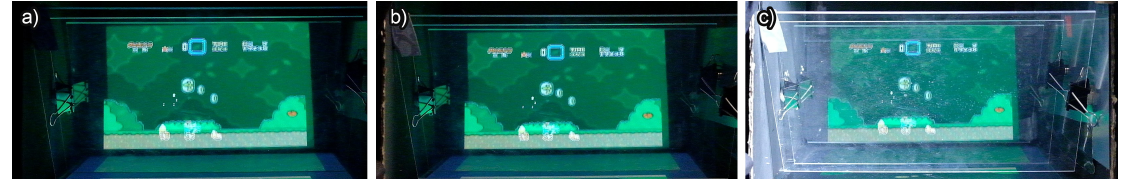
Figure 17. ( a ) SliceView on a completely dark environment, ( b ) under a regular household light bulb, and ( c ) under an LED